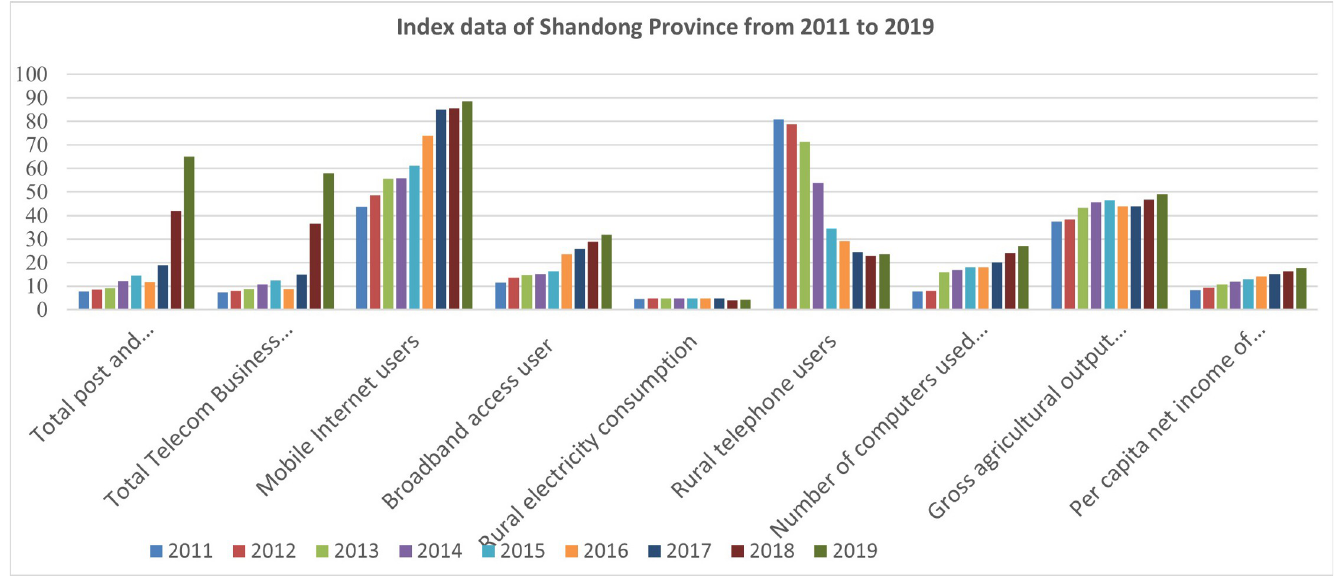
Fig 1. Indicator data of Shandong Province from 2011 to 2019. Data source: China Statistical Yearbook (http://www.stats.gov.cn/tjsj/ndsj/) and Shandong Statistical Yearbook (http://tjj.shandong.gov.cn/col/col6279/index.html).